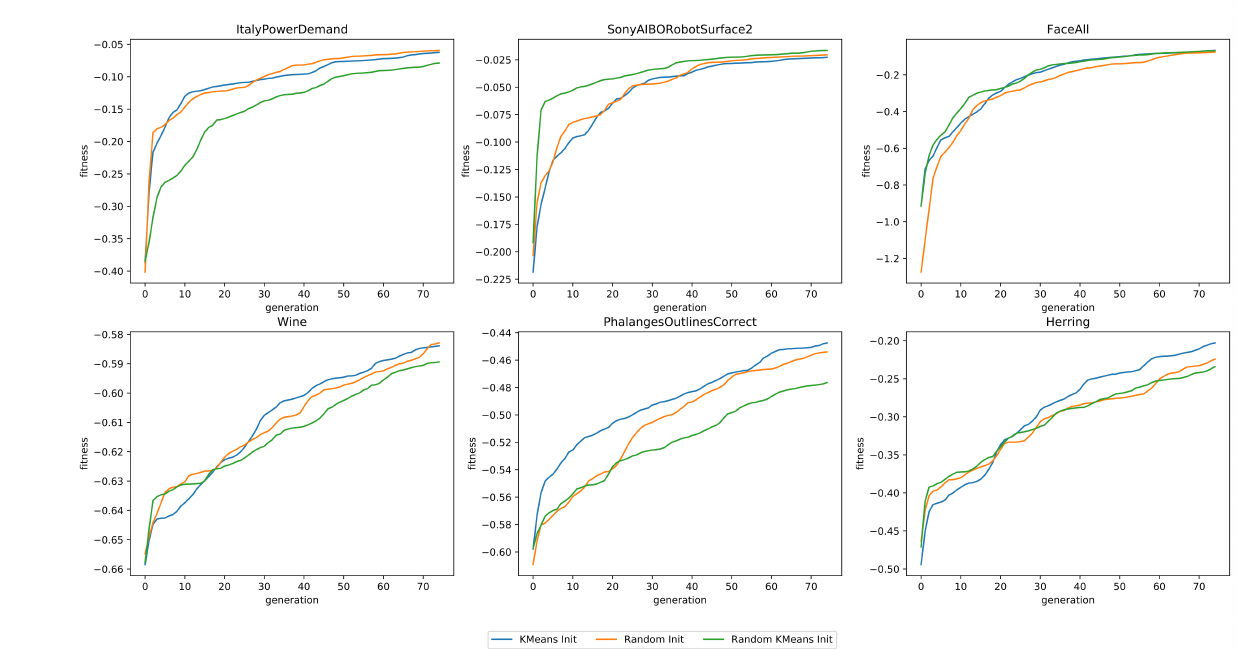
Figure 6. The fitness as a function of the number of generations, for six datasets, using three different configurations of initialization